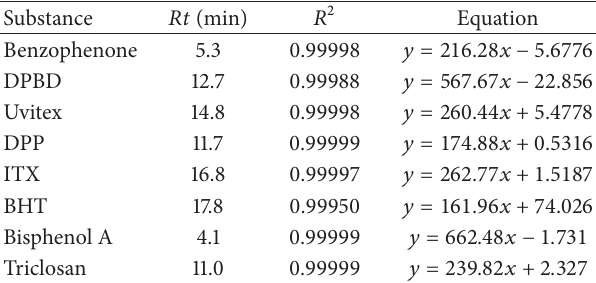
Table 4: Calibration curves and retention times of analyzed sub-